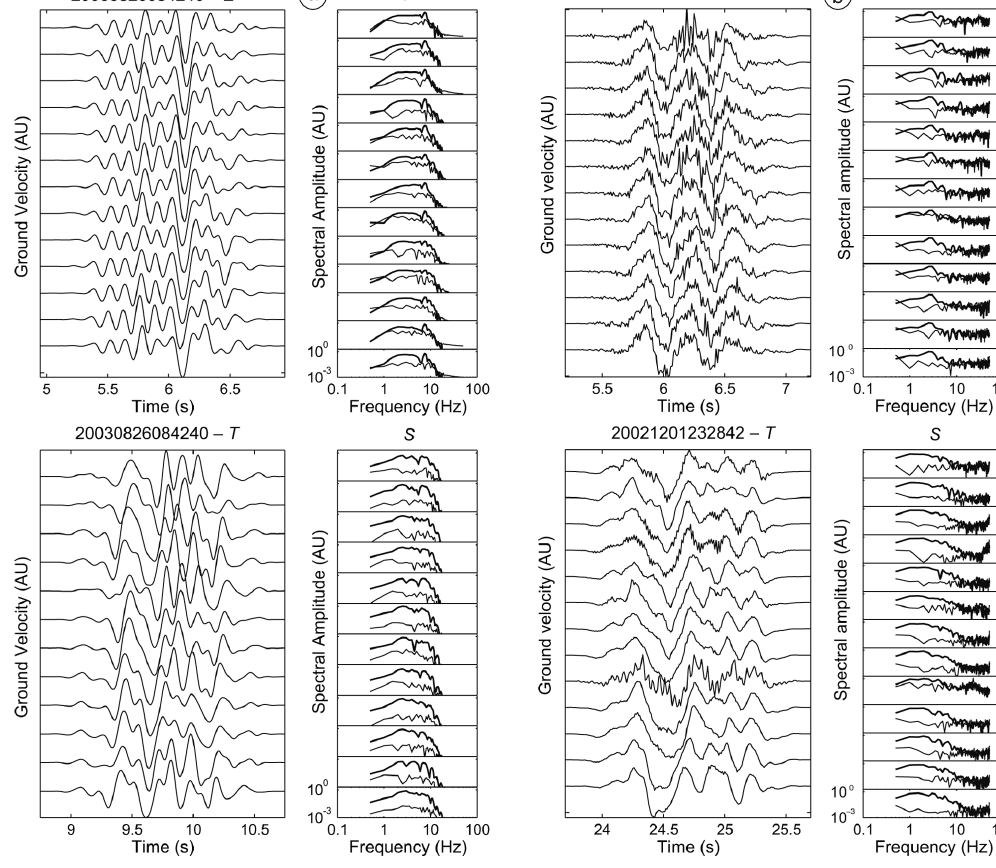
Fig. 6a,b. a) Raw velocity seismograms and amplitude spectra for the P - and S -wave arrivals as recorded by the vertical-and rotated transverse-component, respectively, for a M d = 2.4 earthquake on August 26, 2003, at 08:43:56 GMT. The epicentral range is about 25 km. Seismograms and spectra are normalized to the largest-amplitude trace. Thin lines in the spectral plots refer to noise spectra calculated over 2-s-long windows preceeding the onset of the event. b) The same as in a), but for a M d = 3.3 earthquake on December 1, 2002, at 23:29:23 GMT. The epicentral range is about 124